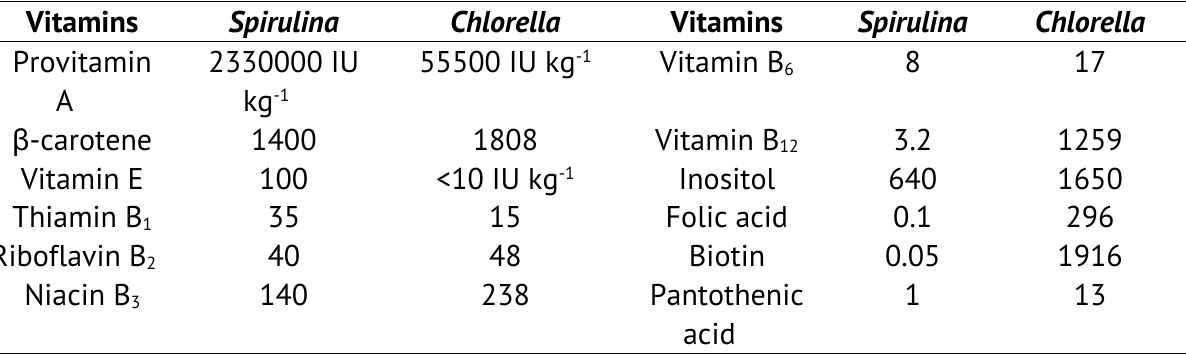
Vitamin profile of two species of microalgae: Spirulina and